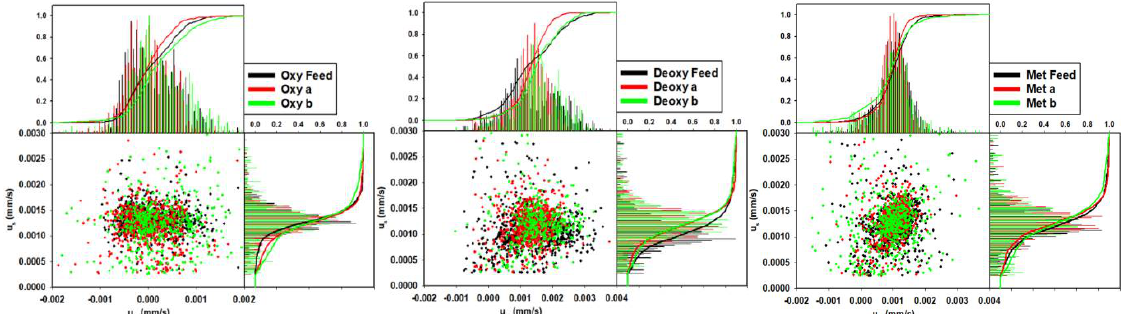
Figure 7. CTV data between outlets for oxygenated, SCD RBCs passing through the QMS while PEG is in the buffer. After separation, the RBCs are oxygenated ( left ), deoxygenated ( center ), and oxidized ( right ), and scatter plots of the trajectories are shown. There is significant shift in magnetic mobility in the x-axis for the oxygenated and deoxygenated states, but the metRBCs from both outlets have the same mobility. This leaves several questions about the effects of density, shape and Fe oxidation state in post-transfusion SCD blood.